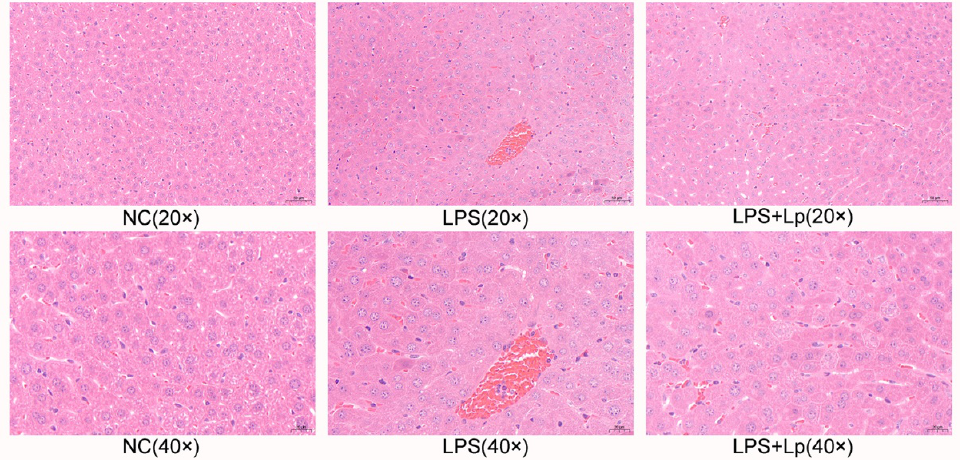
Figure 3. Representative H&E staining of liver sections (scale bar: 50 μm).